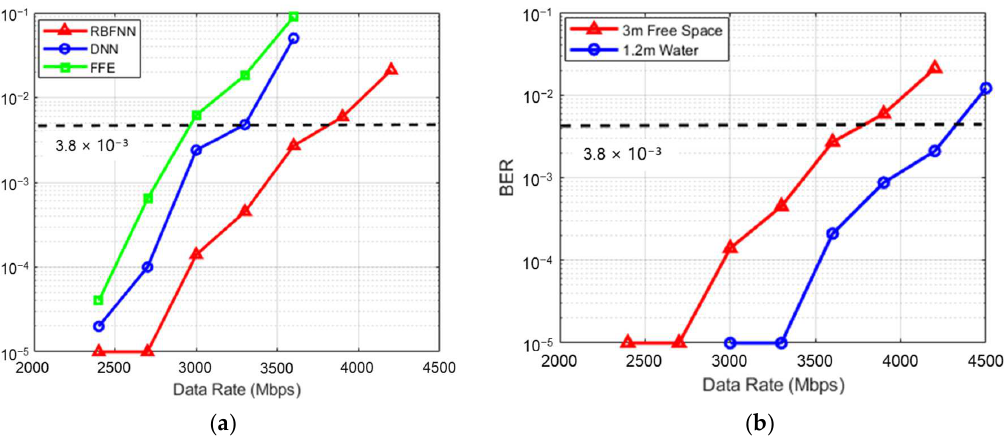
Figure 16. Simulated results of BER vs. data rate: ( a ) using RBF-NN, DNN, or FFE as a post-equalizer with 3 m free-space channel; ( b ) 3 m free-space and 1.2 m water channel with RBF-NN. The simulated received eye diagrams using the RBF-NN as a post-equalization scheme at two different data rates with two types of channels are presented in Figure 17.